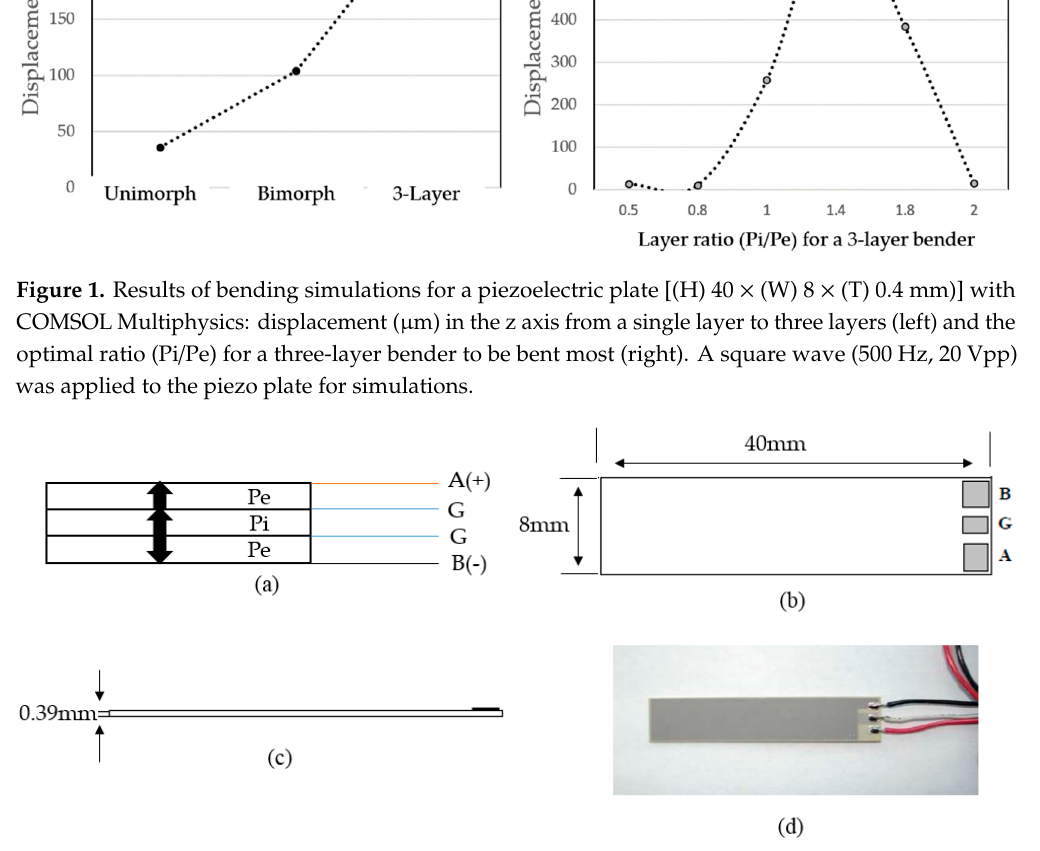
Figure 2. Final design ( a – c ) of a three-layer piezoelectric actuator based on the results of simulations and ( d ) is a manufactured actuator. Pe and Pi are 0.1 mm and 0.14 mm, respectively. A and B are positive and negative electrodes, and G is the ground, respectively. The final thickness (0.39 mm) was estimated including bonding.